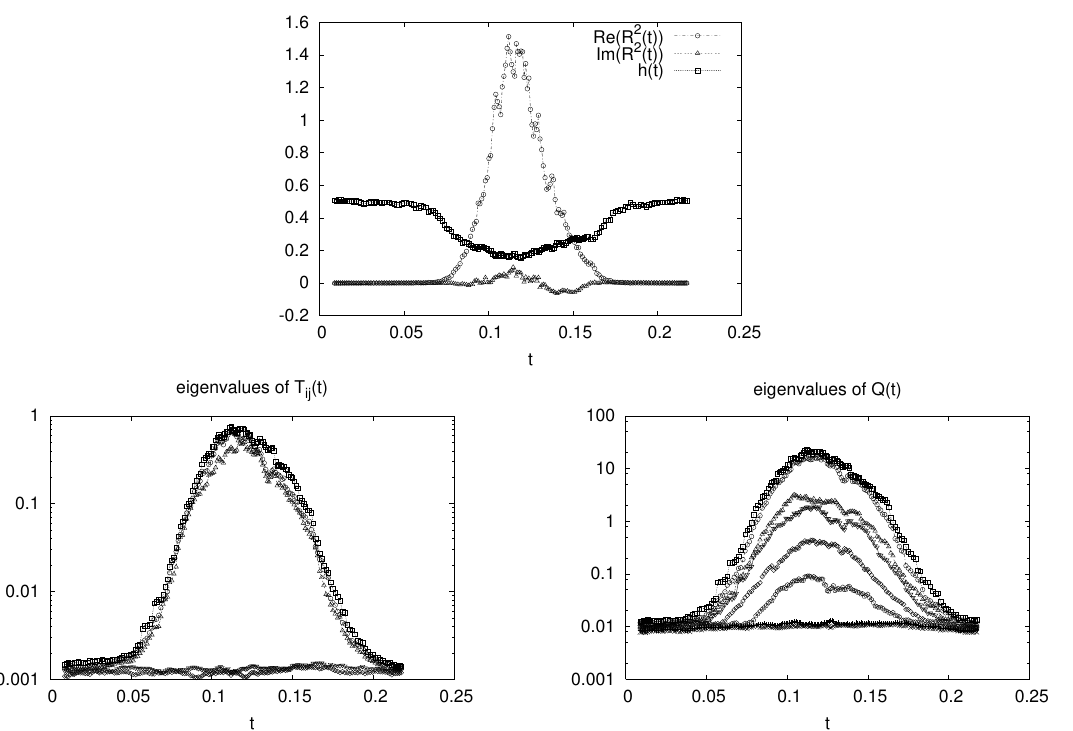
Figure 3 . Results for ( s, k ) = (0 . 0118 , 0 . 5059), N = 192, κ = 0 . 0044, β = 64, n = 24 are shown. (Top) The real and imaginary parts of R 2 ( t ) are plotted against t . The Hermiticity norm h ( t ) of the matrix ¯ A i ( t ) is also plotted. (Bottom-Left) The five eigenvalues of the moment of inertia tensor are plotted against t in the log scale. (Bottom-Right) The eight largest eigenvalues of the matrix Q ( t ) are plotted against t in the log